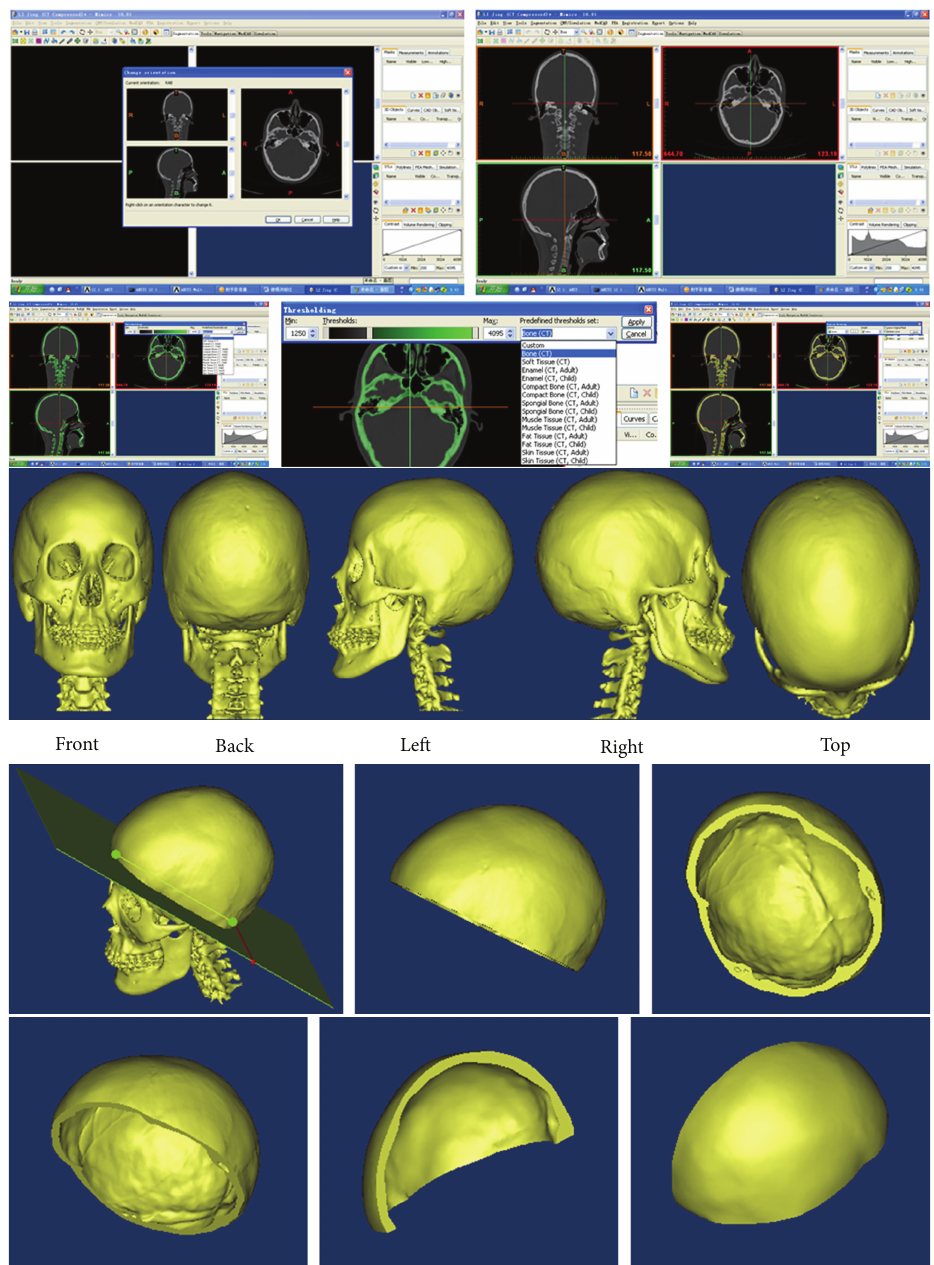
Figure 16: 3D model of cranial